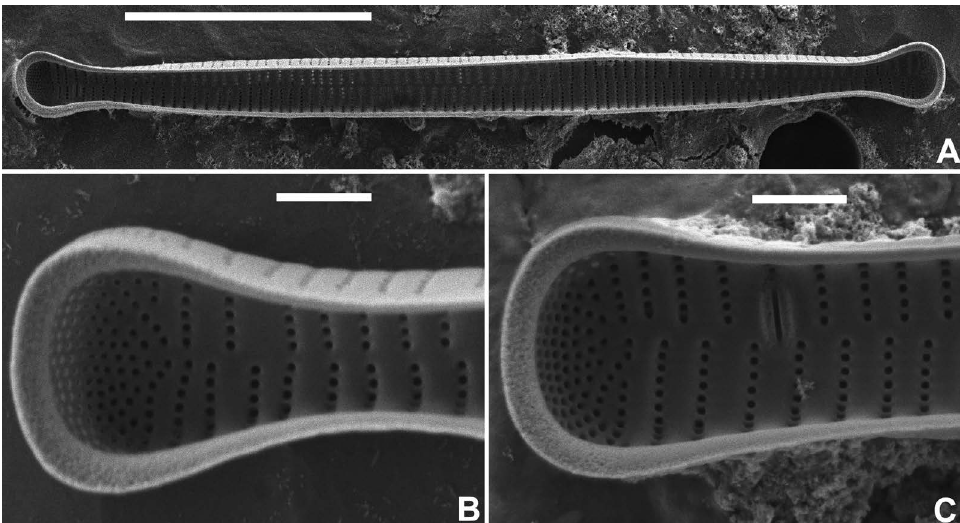
Figure 3 – Distrionella coxiana , SEM of the type population from Rancho Hambre, Tierra del Fuego (sample RH2016-CP4-PER2): A, SEM internal view of an entire valve; B, SEM internal detail of the valve apex showing the apical porefield but lacking a rimoportula; C, SEM internal detail of the valve apex showing the apical porefield and the rimoportula. Scale bars: A = 10 µm; B & C = 1